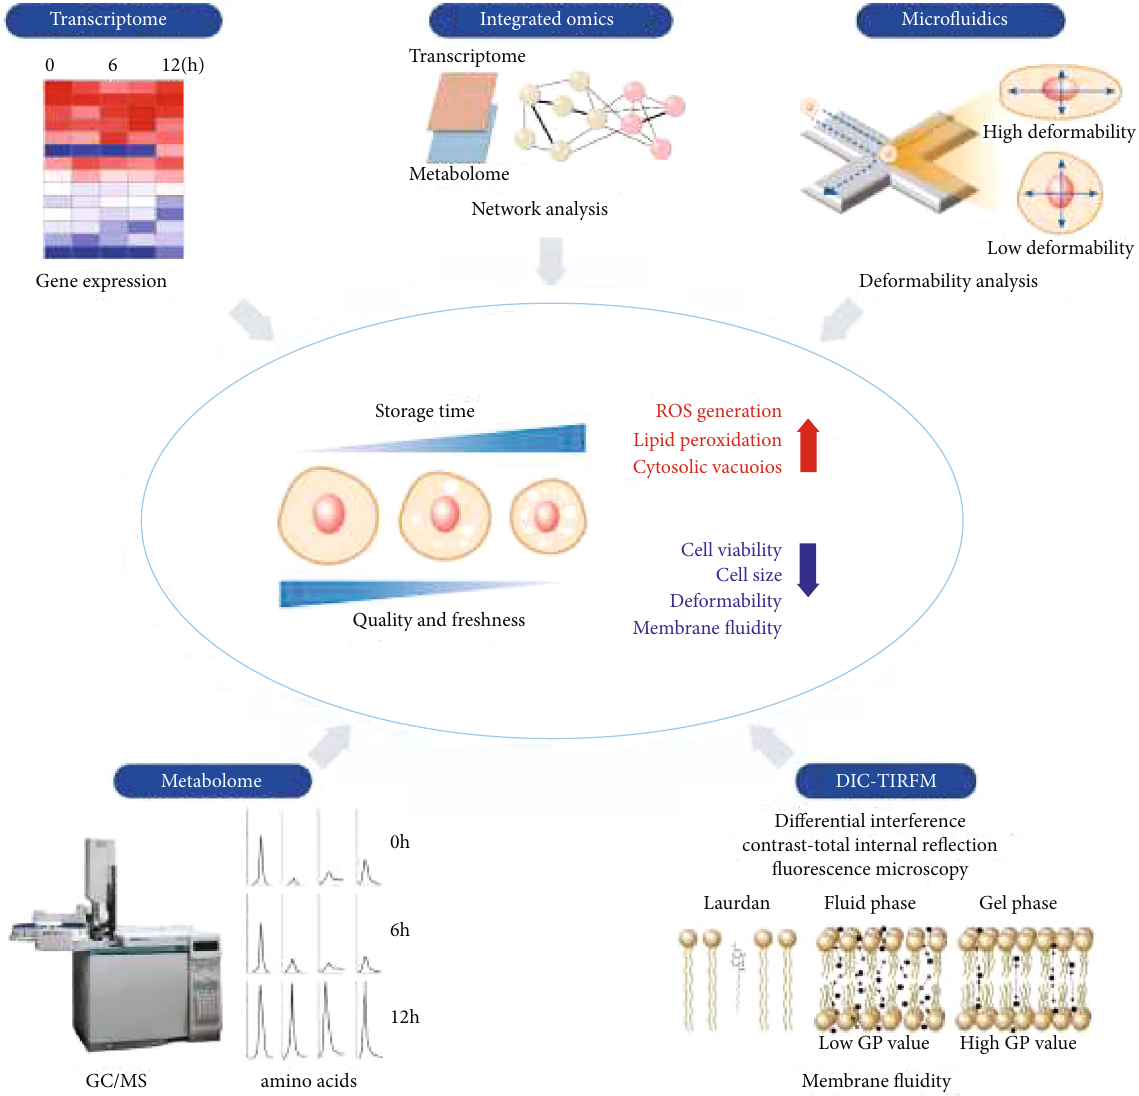
Figure 1: The quality and freshness of human bone marrow-derived mesenchymal stem cells (hBM-MSCs) are decreased over time after detachment from the culture dish. To evaluate the freshness and quality of hBM-MSCs, the metabolome is analyzed using gas chromatography – mass spectrometry (GC/MS), the transcriptome is analyzed using microarray, deformability is analyzed using micro fl uidics, and membrane fl uidity is tested using di ff erential interference contrast- (DIC-) total internal re fl ection fl uorescence microscopy (TIRFM) in combination based on previous reports [9,